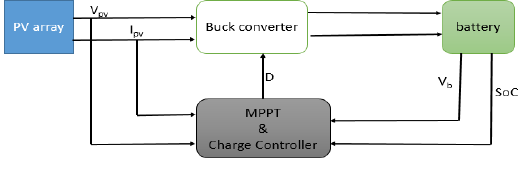
Figure 2 . Battery charging